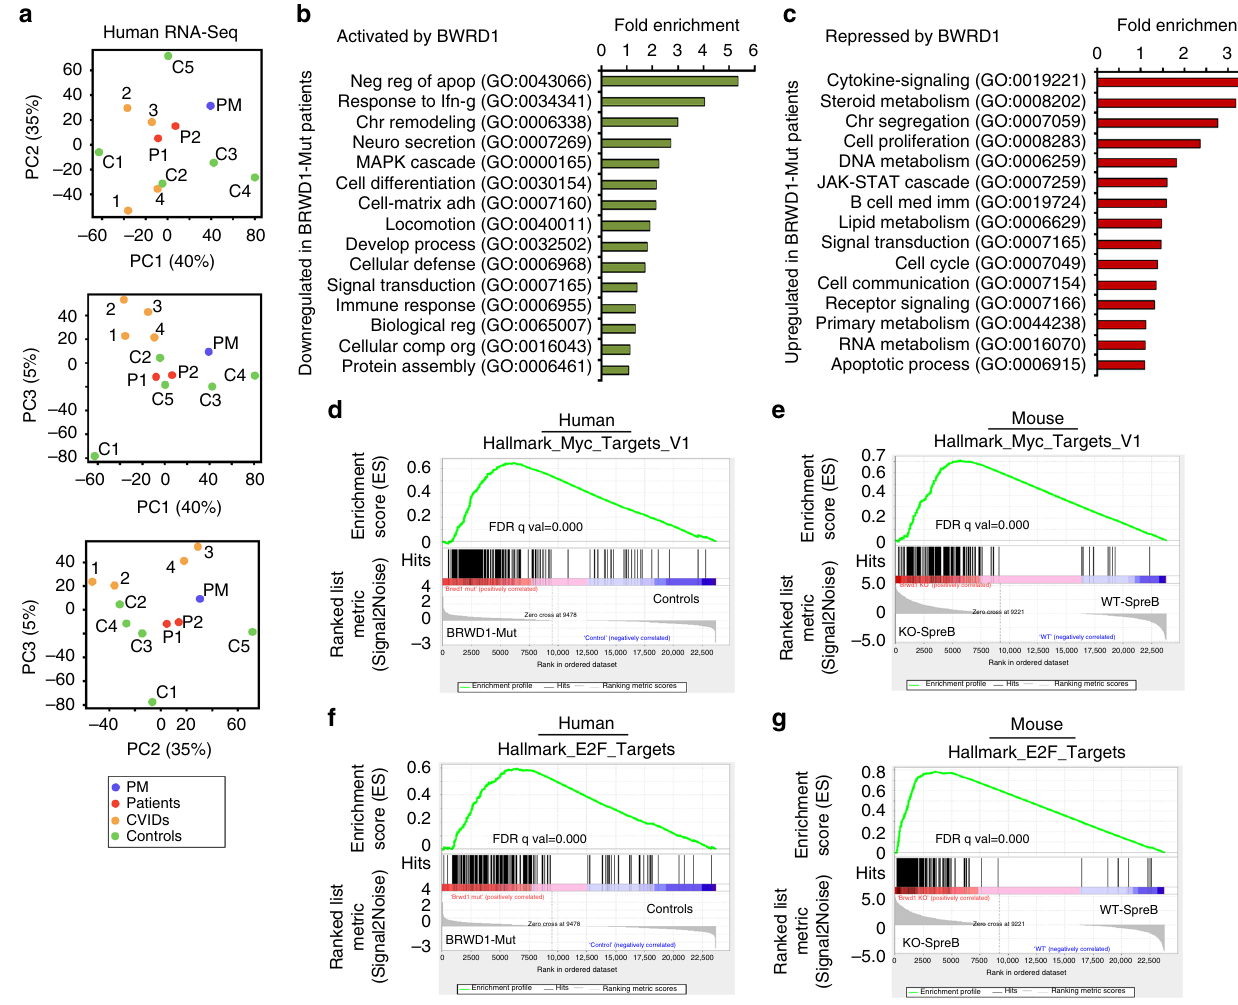
Fig. 6 Human BRWD1 represses proliferative gene expression program. a Principal component analysis of mRNA expression in all the EBV-transformed human peripheral blood B cells from patients (P1 and P2), controls (C1-5), unrelated CVID patients (CVID1-4) and patients ’ mother (PM). Eigenvalue statistics for the PC analysis of RNA-Seq were reported in axes. b , c Ontology analysis of gene clusters with lower ( b ) or higher ( c ) transcript abundance in BRWD1 -Mut hypogammaglobulinemic patient group (P1-2 than in control group, C1-5). Only terms with FDR < 5%, P < 0.05 and over log 2 2 fold enrichment were reported. The numbers in the parenthesis indicate the associated pathway. d , e Gene set enrichment analysis (GSEA) of MYC pathway enriched in P1/2 relative to controls ( d ) and Brwd1 -/- small pre-B cells compared to WT small pre-B cells ( e ). f , g Gene set enrichment analysis (GSEA) of E2F pathway enriched in BRWD1 -Mut patient group relative to controls ( f ) and Brwd1 -/- small pre-B cells compared to WT small pre-B cells ( g